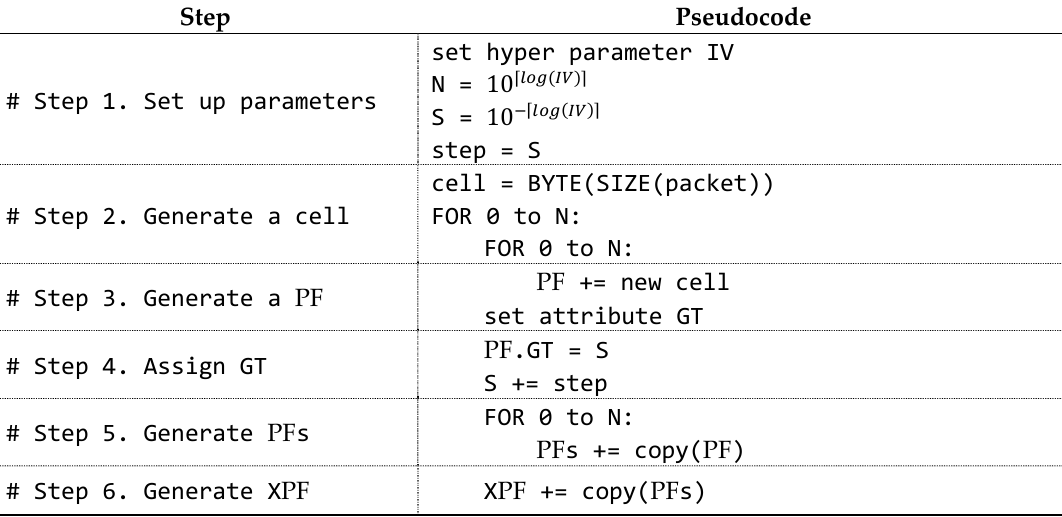
Figure 4. Algorithm of the XPF creation procedure .